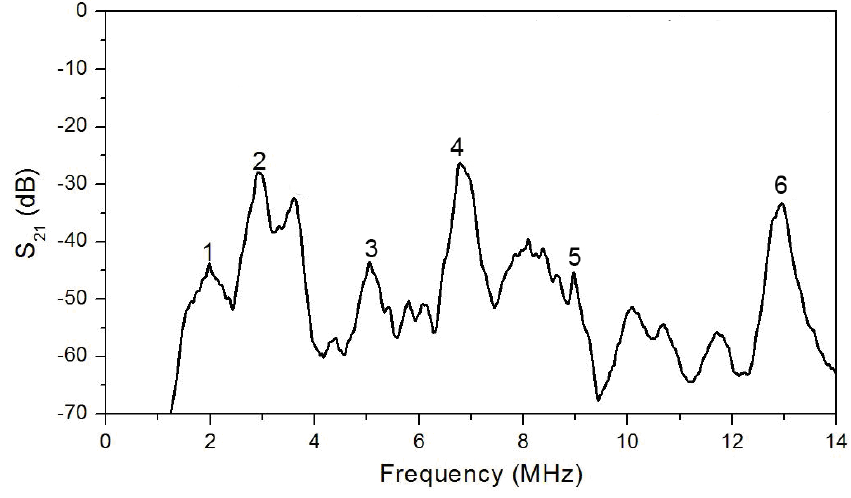
Figure 9. Frequency dependence of IDT transmission parameter S 21 for produced delay line based on YX LiNbO 3 plate.